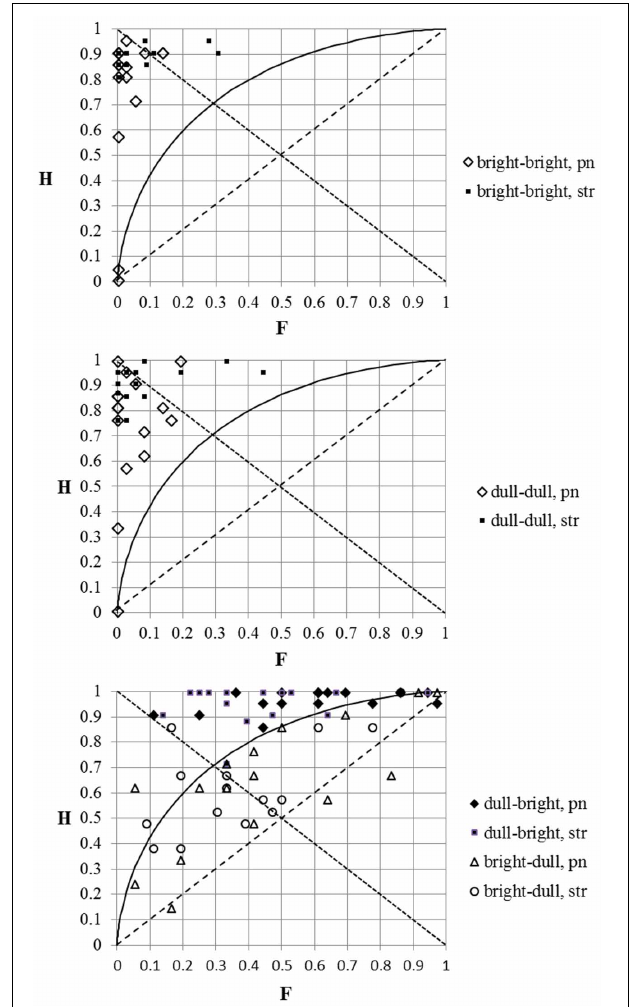
FIGURE 6 | Individual data-points of the SDT analysis at different timbral arrangements of comparable tones (see separate panels). Diamonds—the data-points of pianists; squares—the data-points of string players. Only the replies to the stimulus-pairs with (cid:2) F 0 = 20 cents and zero cents were included in the analysis.